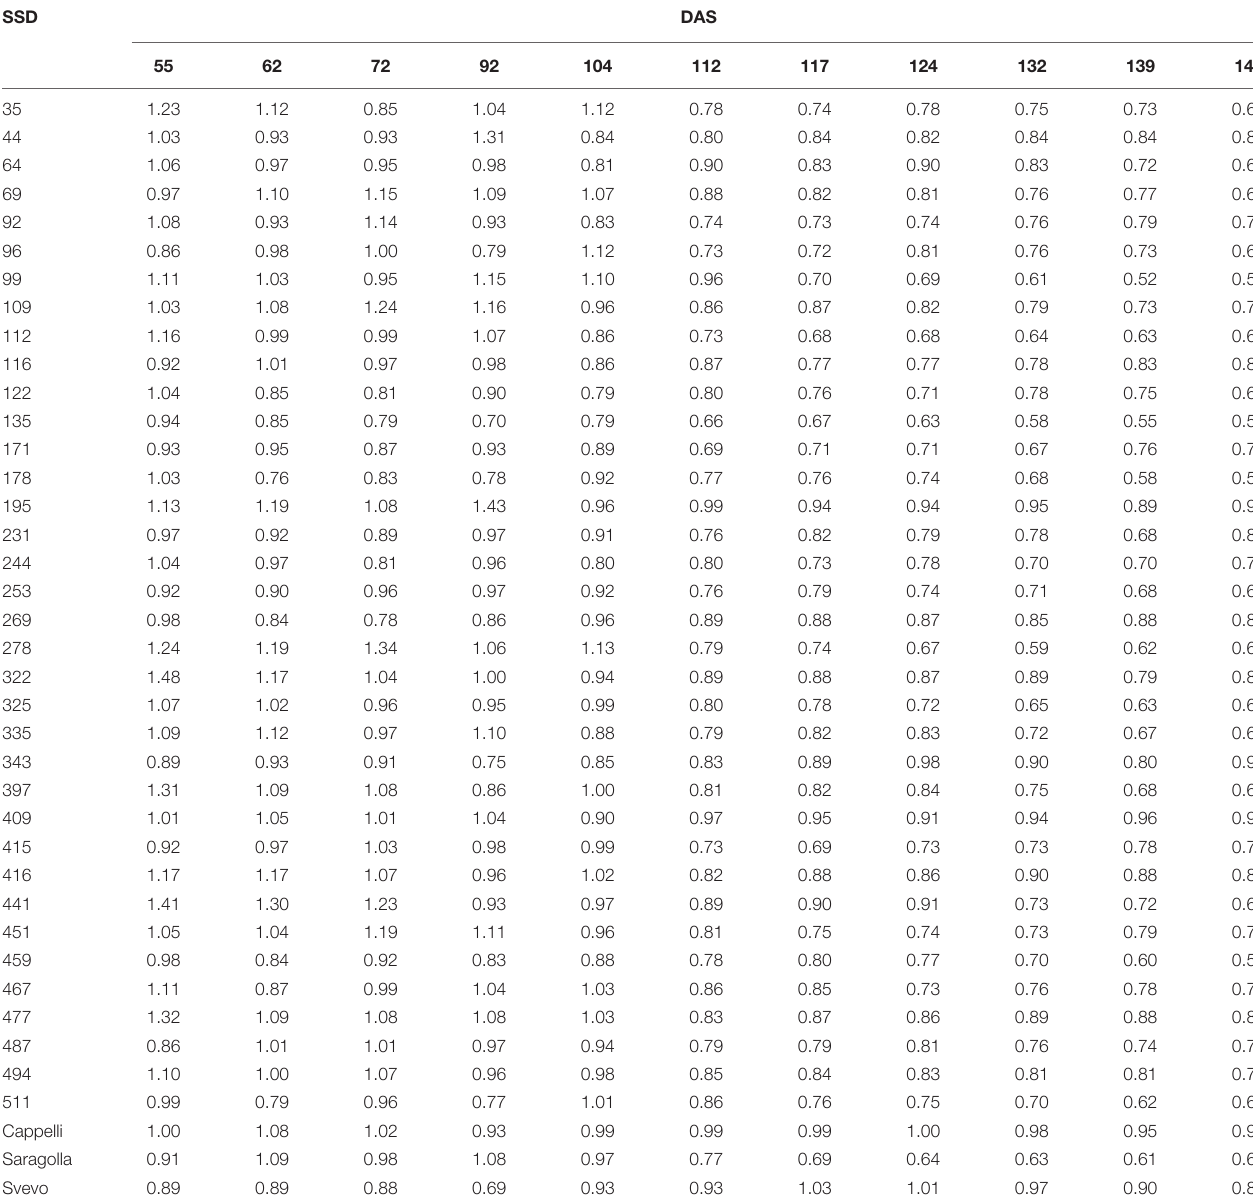
TABLE 3 | Digital Biovolume Ratio (DBR) calculated for all SSD genotypes tested and control varieties for the entire experiment length.